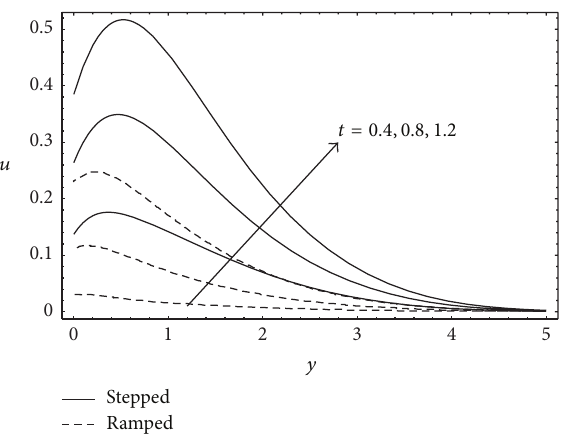
Figure 6: Temperature profiles for two different values of Pr.